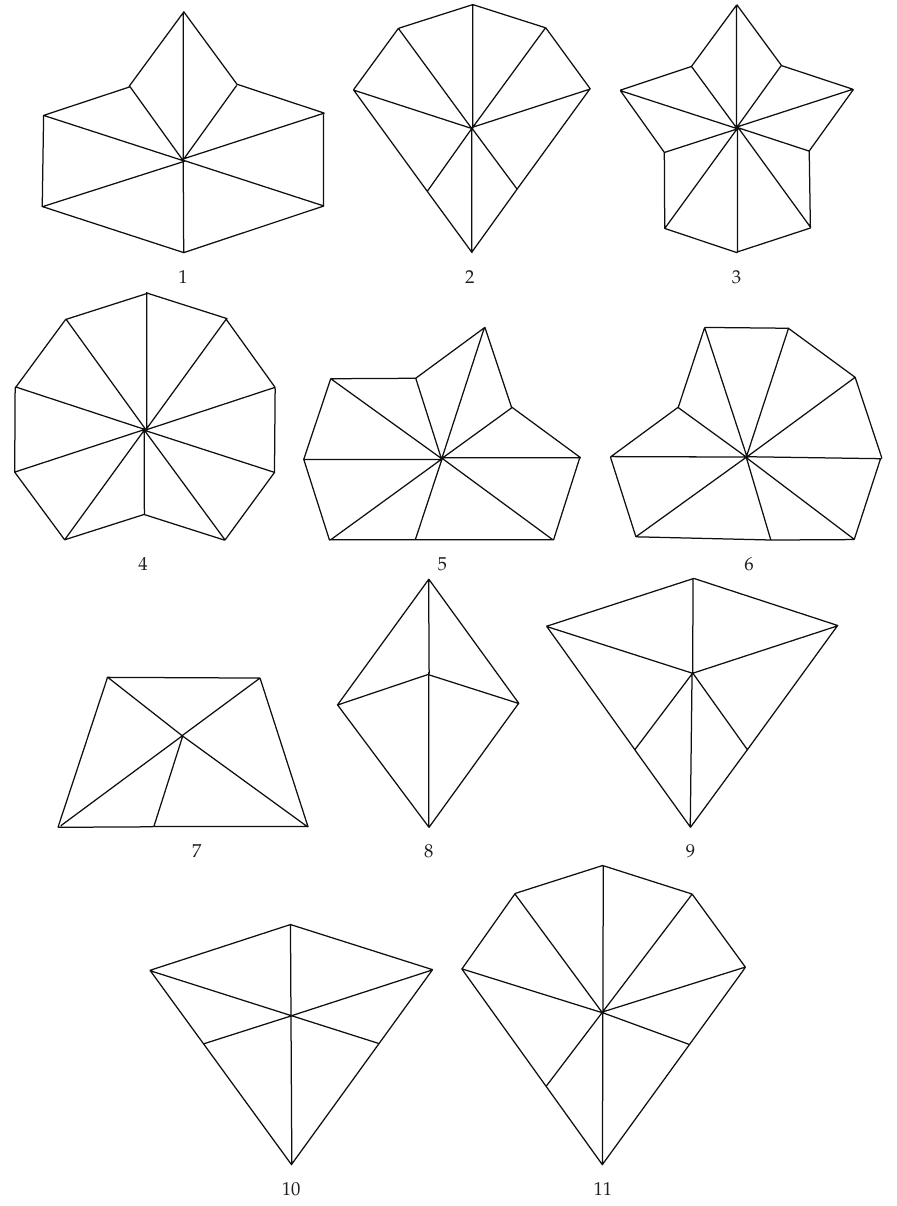
Figure 13: Atlas of vertex configurations of T −